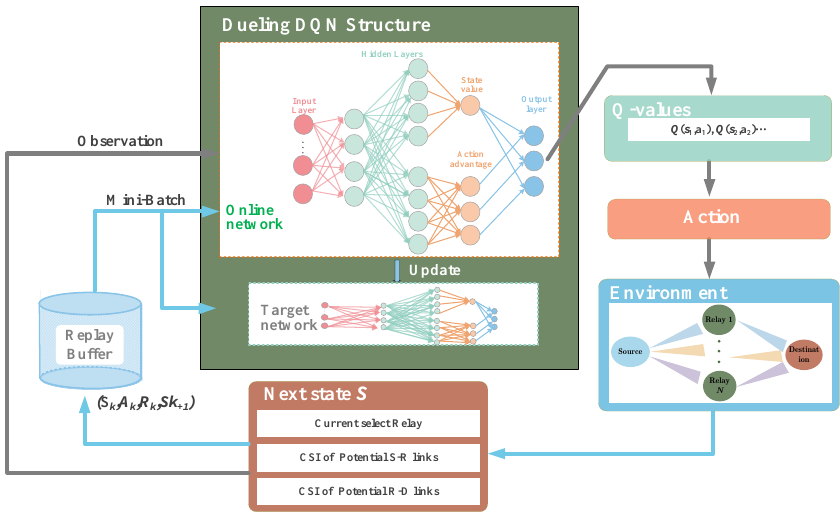
Figure 3. Proposed DQN-RS algorithm framework.